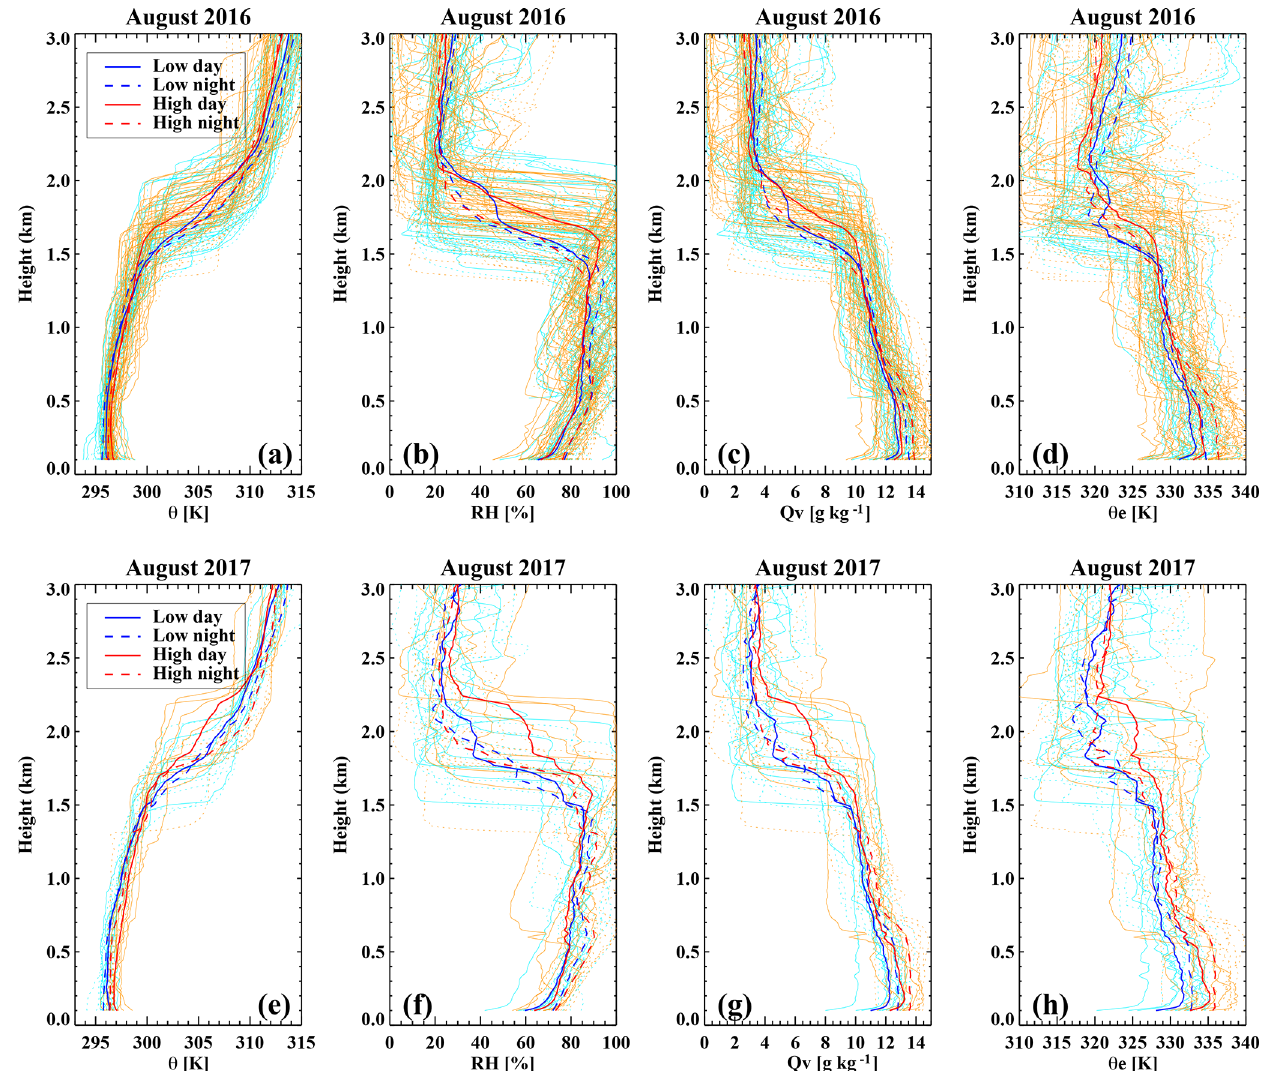
Figure 13. Radiosonde-derived vertical profiles of (a, e) potential temperature ( θ ), (b, f) relative humidity, (c, g) water vapor mixing ratio ( Q v ), and (d, h) equivalent potential temperature ( θ e ) for August 2016 (a–d) and 2017 (e–h) , shown individually and as composite means (thicker solid lines for daytime, thicker dashed curves for nighttime) for “more” (red) and “less” (blue) smoke loadings. The smoke loadings are based on hourly-mean rBC values centered on the radiosonde launch time. 92 and 63 profiles contributed to the “more” and “less” smoke loading distribution, respectively, in 2016, and 29 and 27 profiles respectively in